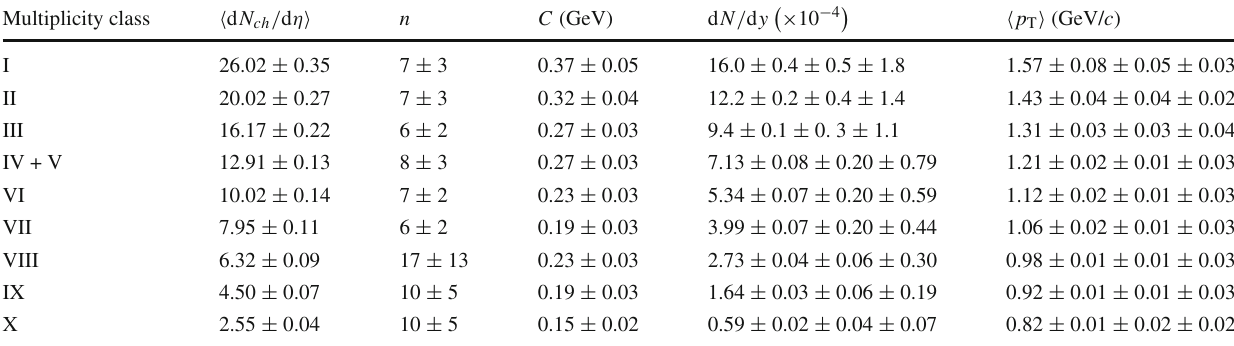
Table 1 Summary of the relevant information about the multiplicity classes and the fits to the measured transverse momentum spectra of anti-deuterons. (cid:4) d N ch / d η (cid:5) is the mean pseudorapidity density of the primary charged particles [25]. n and C are the parameters of the Lévy–